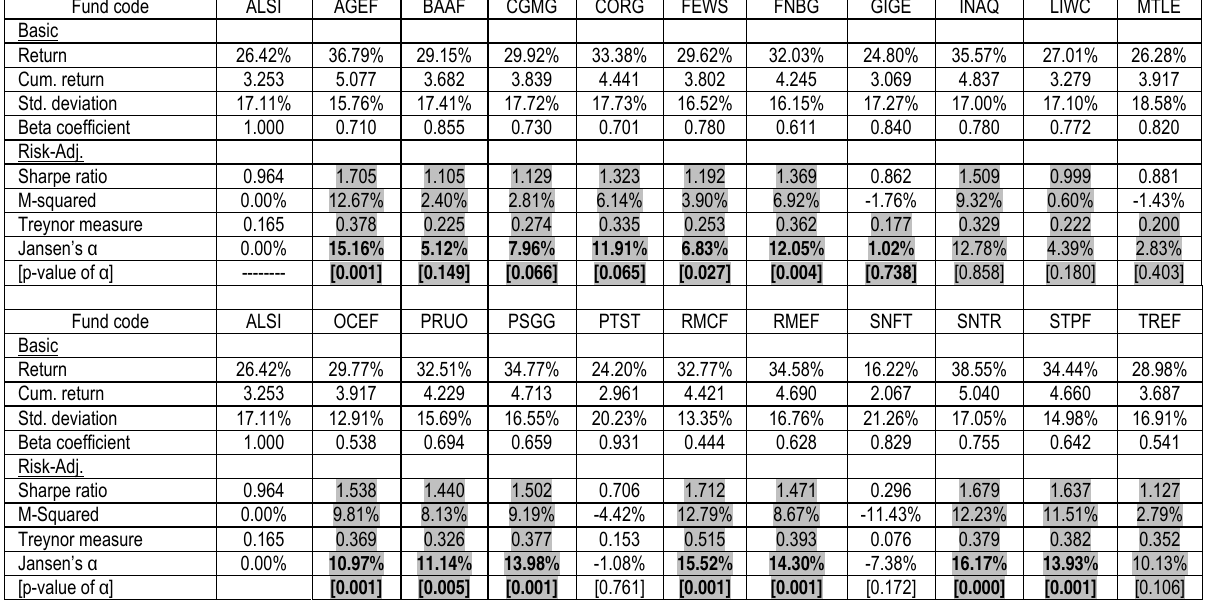
Table 1. Fund performance (Sub-period 1: 6 Jan 2002 to 6 May 2007)